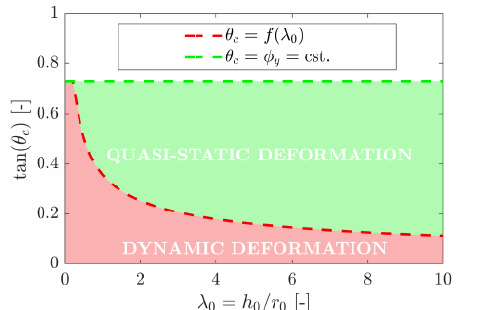
Figure 11. Difference between quasistatic (sand pile, green area) and dynamic deformations (collapse, red area) of the granular column: tan ( θ c ) expresses the ratio h ∞ / r ∞ and shows a significant decrease when θ c = f ( λ 0 ) . It also indirectly expresses the increase in energy loss due to elastoplastic collisions during the inertial deformation of the